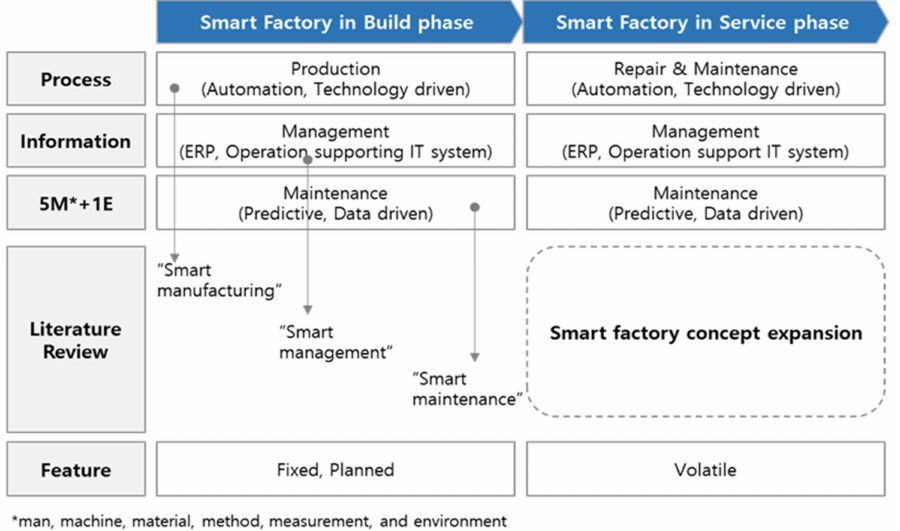
Figure 2. Research on smart factory and